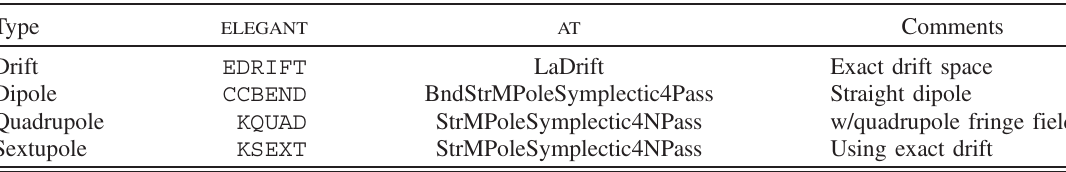
TABLE I. New single particle dynamics features in ELEGANT and AT . (Note that the KQUAD and KSEXT elements have been standard in elegant for many